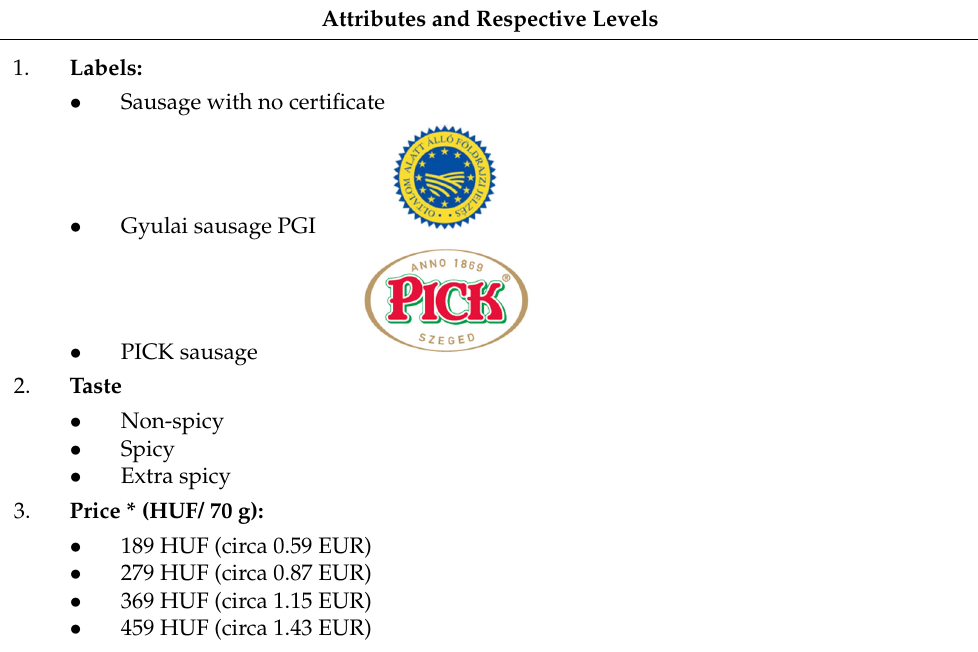
Table 1. Attributes and respective levels used in the Discrete Choice Experiment.